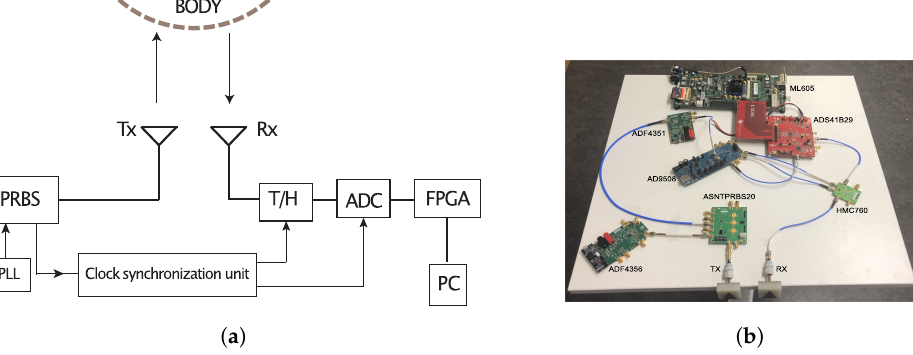
Figure 2. The block diagram of the developed sensor in Figure ( a ) and the measurement setup for vital sign monitoring in Figure ( b